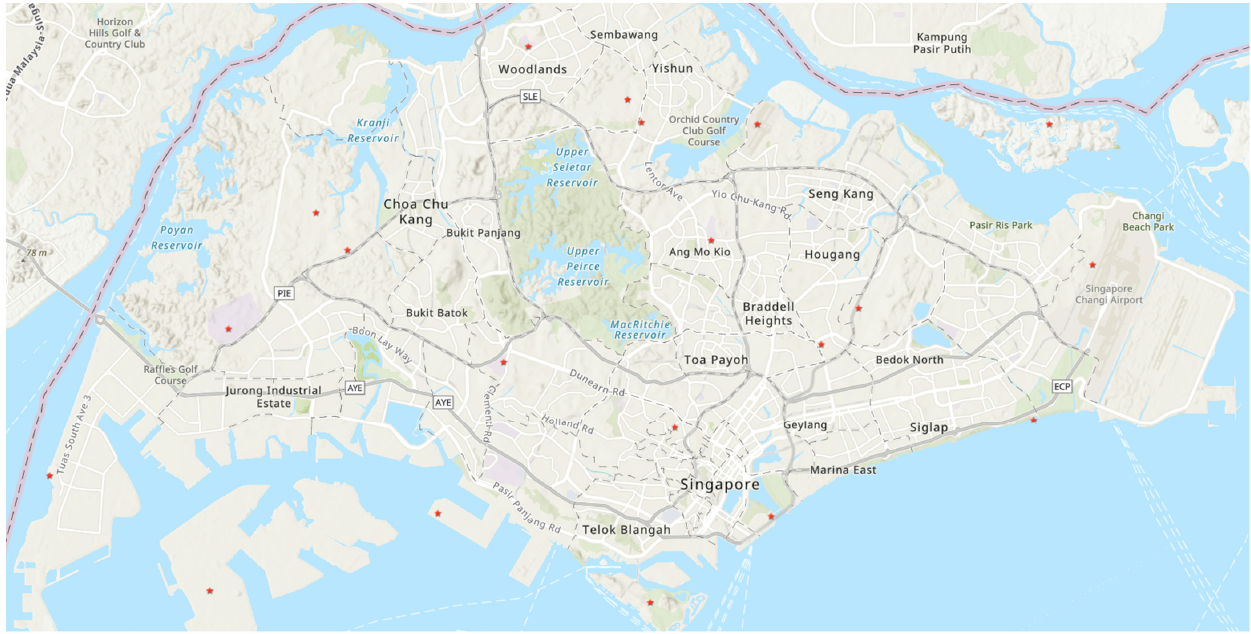
Figure 2. Based on longitude and latitude details, an overall illustration of the locations of the weather stations in Singapore was plotted in red stars